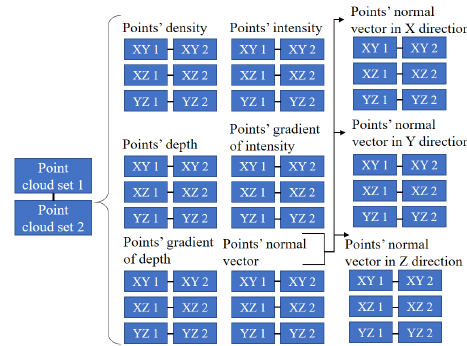
Figure 13. The 27 produced image pairs from each overlapping point cloud